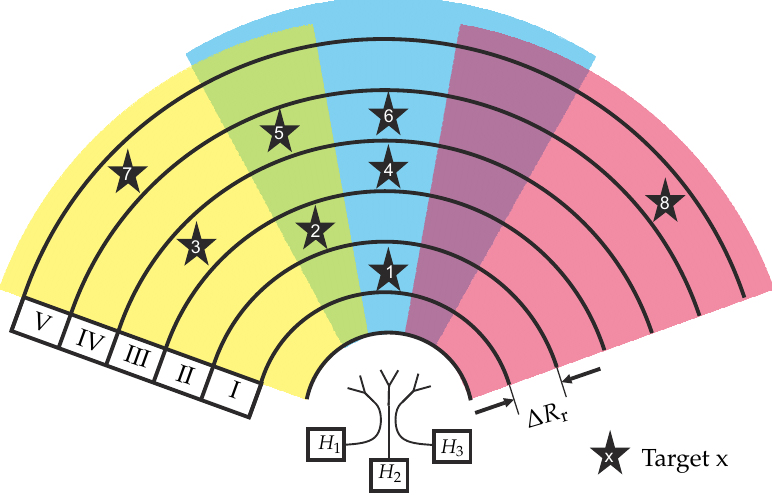
Figure 2. Illustration of different radar scenarios occuring for coded RX-channel overlay operation.